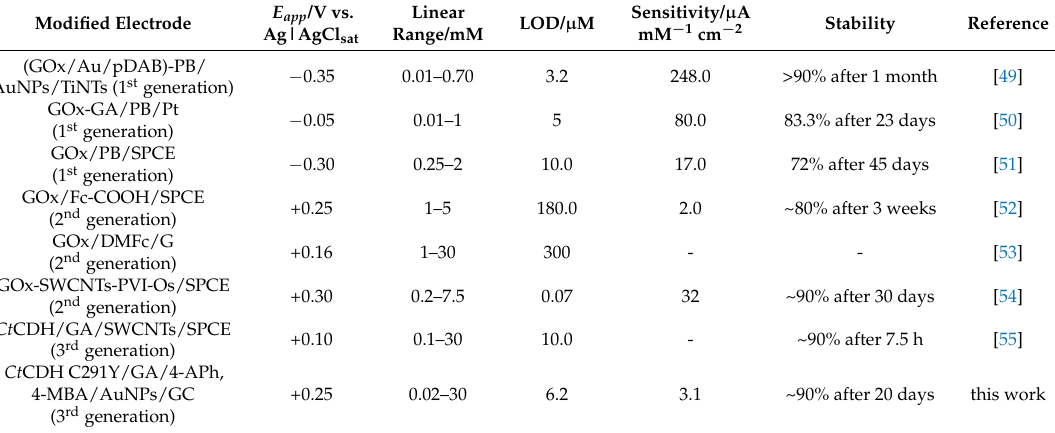
Table 3. Comparison between glucose biosensors based on mediated (MET) and direct electron transfer (DET). List of abbreviations: 1,1 (cid:48) -dimethylferrocene (DMFc), 1,2-diaminobenzene (p-DAB), 4-aminophenol (4-APh), 4-mercaptobenzoic acid (4-MBA), Corynascus thermophilus cellobiose dehydrogenase ( Ct CDH), Corynascus thermophilus cellobiose dehydrogenase C291Y mutant ( Ct CDH C291Y), ferrocene-COOH (Fc-COOH), glassy carbon electrode (GC), glucose oxidase (GOx), glutaraldehyde (GA), gold (Au), gold nanoparticles (AuNPs), osmium (bpy) 2 poly (1-vinylimidazole) (PVI-Os), Prussian Blue (PB), screen-printed carbon electrode (SPCE), single walled carbon nanotubes (SWCNTs), titanium nanotubes